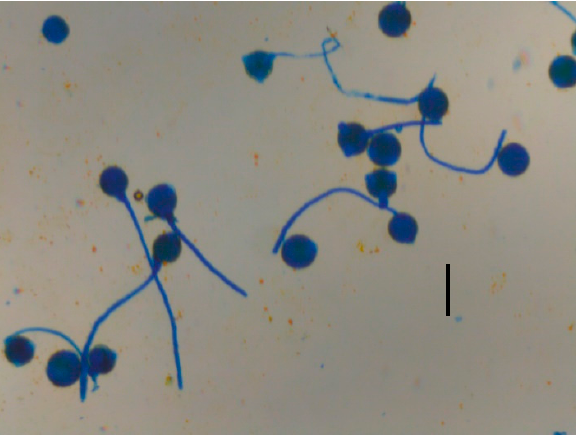
Figure 1. Germinated Gac pollen showing pollen tube growth (stained with aniline blue, bar rep- resents 100 µm). represents 100 µ